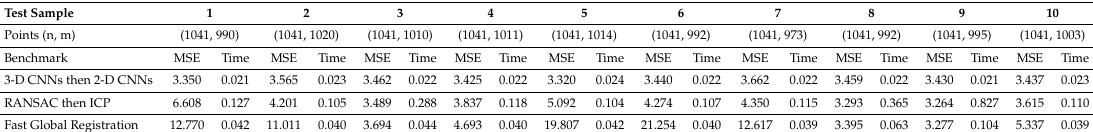
Table 5. The comparisons about MSE and computation time of “Dragon” data for test samples from 1 to 10. TestSample